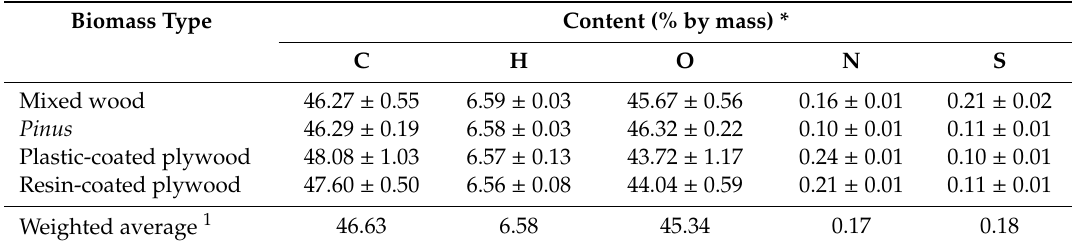
Table 3. Ultimate analysis results.